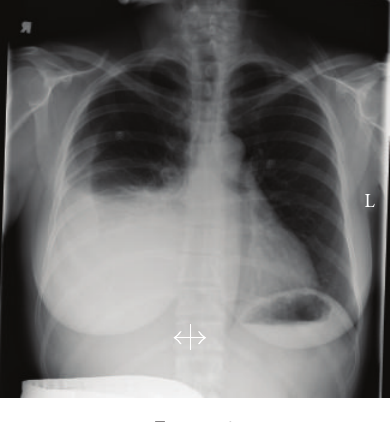
with a hematocrit of 41, which had decreased from a peak level of 48. Her serum sodium normalized at 136 meq/L after rising from a nadir of 130 meq/L. Serum beta hCG was 134 mIU/mL on day 28 and rose